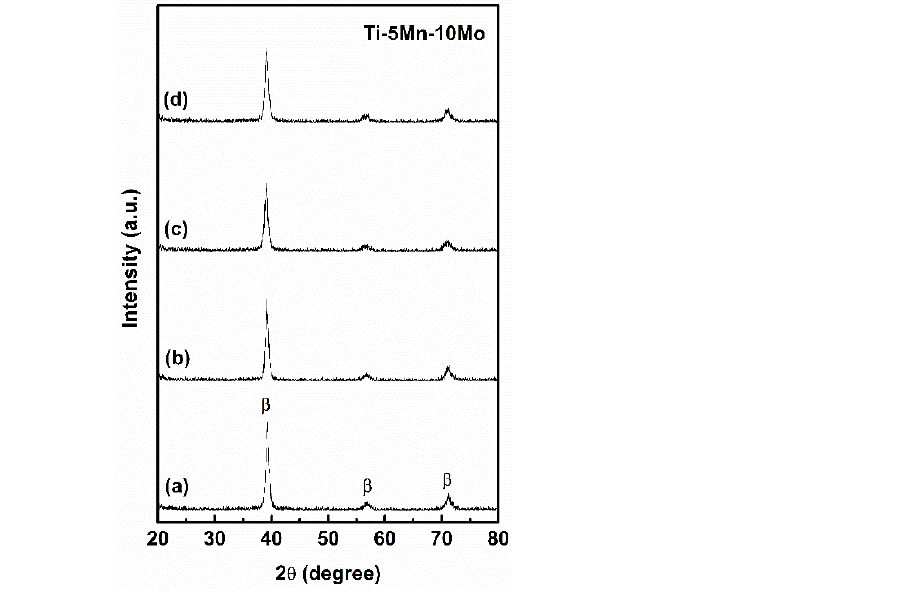
Figure 1. X-ray diffractograms for Ti-5Mn-10Mo alloy after homogenization heat treatment ( a ), after the hot-rolling process ( b ), and after the solution ( c ) and annealing ( d ) heat